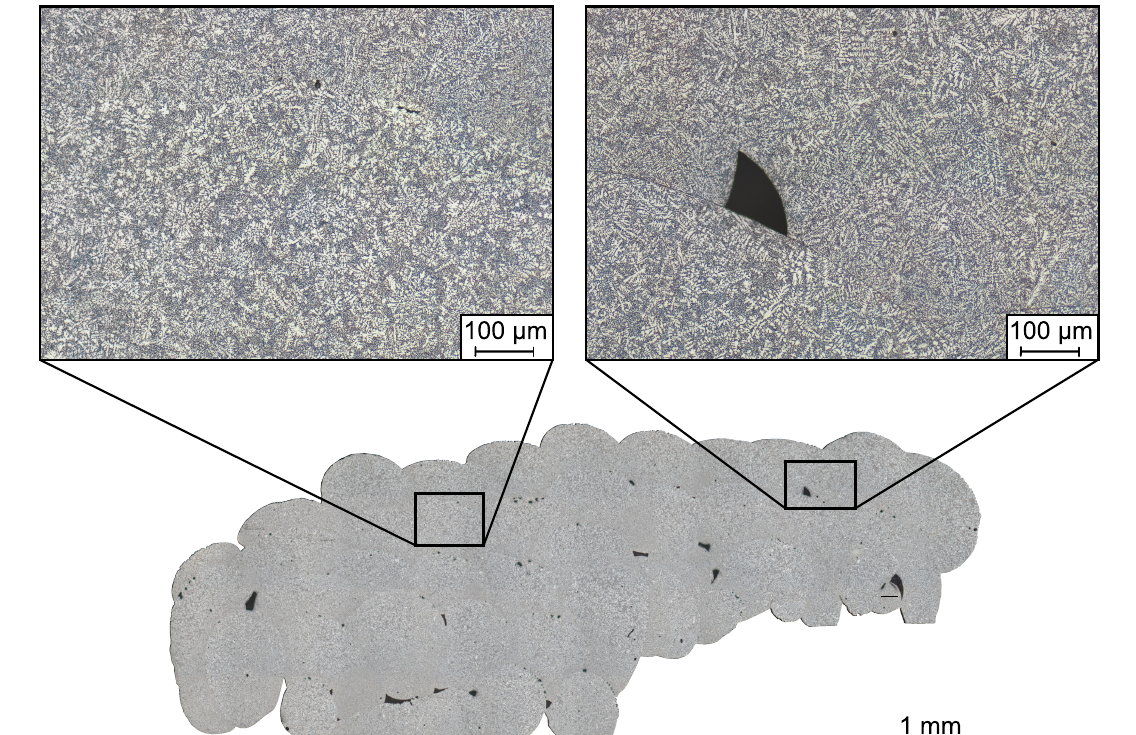
Figure 7. Cross-sectional area of UL-sample etched with two percent aqueous sodium hydroxide solution. The images above the cross-sectional area show the detailed views of the material microstructure of the sample area above the aluminum (left side) and above the salt support structure (right side). In the area above the salt support structure, a coarser dendrite structure can be observed.